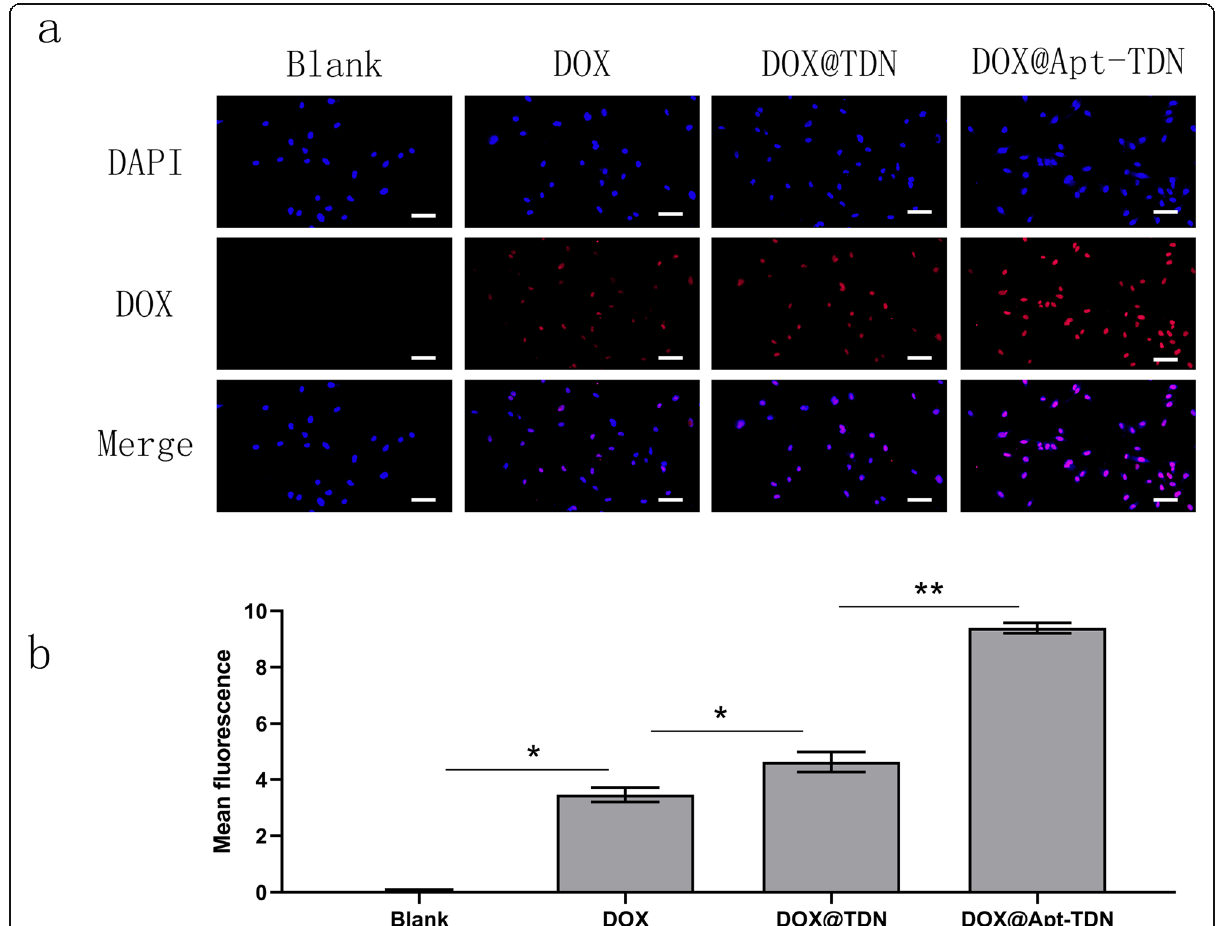
Fig. 5 a Cellular uptake of DOX, the DOX@TDN, and the DOX@Apt-TDN. Modified with the aptamer Gint4.T, the Apt-TDN could deliver more doxorubicin to U87MG cells than the TDN. In addition, the TDN could carry more drug to cells than the drug alone. The scale bars indicate 50 μ m. b Semi-quantitative analysis of the fluorescence intensity of doxorubicin with PBS, DOX, DOX@TDN, and DOX@Apt-TDN treatment (compared to blank: * p < 0.05, ** p <